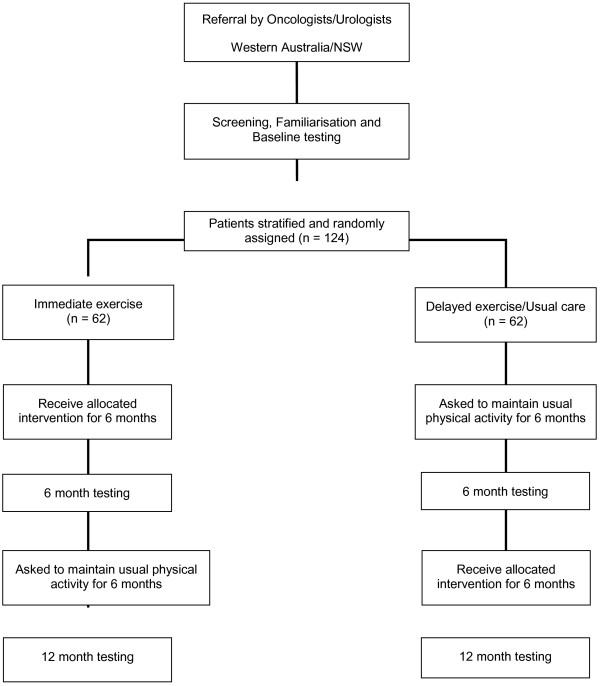
CONSORT Diagram.